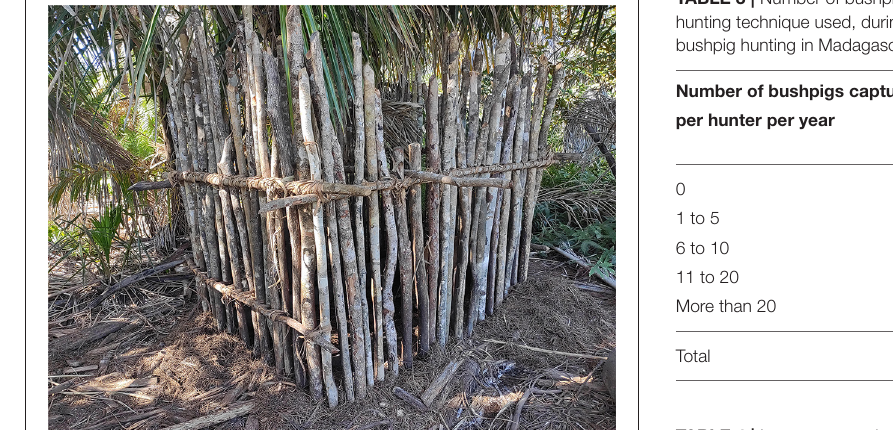
TABLE 4 | Importance and economic contribution of bushpig meat trading during a survey on health and socioeconomic aspects of bushpig hunting in Madagascar,